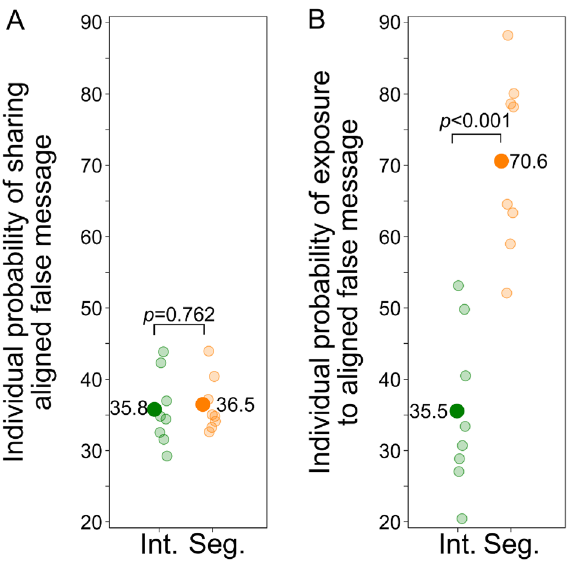
Figure 3. Individual sharing behavior and exposure to misinformation in integrated and segregated networks. ( A ) An individual who receives an aligned false message is just as likely to share it in an integrated network as in a segregated network (two-sided randomization test; ATE =0.7%, p =0.762, N =16). Each shaded circle represents one network. ( B ) By contrast, we find a sizable increase in the number of false aligned messages people receive in a segregated network, identifying the exposure mechanism that underlies the structural effect of network segregation on the spread of misinformation (one-sided randomization test: ATE =35.0%, p =0.0002, N